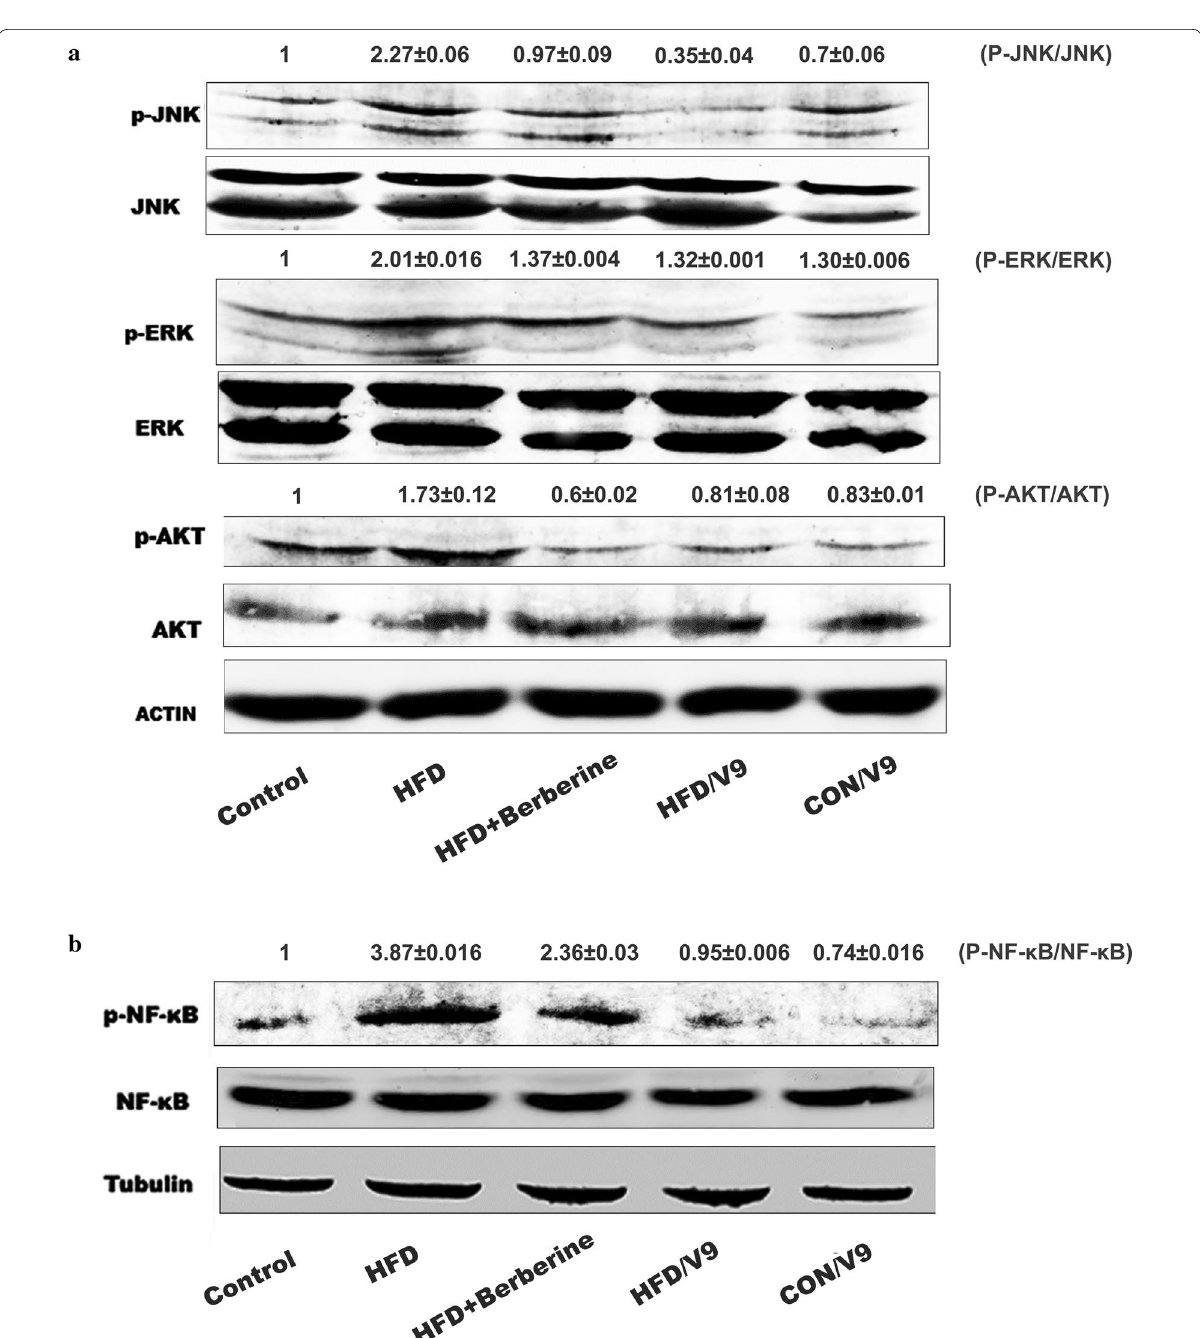
Fig. 6 The effects of probiotic V9 on hepatic MAPK, AKT and NF-κB activation in HFD-challenged rats. a Western blotting analysis of phospho –JNK (p-JNK), total JNK, phospho-ERK (p-ERK), total ERK, phospho-AKT (p-AKT) and total AKT. b Western blotting analysis of nuclear phospho-NF-κB (p-NF-κB) and total NF-κB. The Representative pictures in a and b are shown from three independent experiments. The densitometric analysis of bands from all samples was shown as the fold change relative to the control